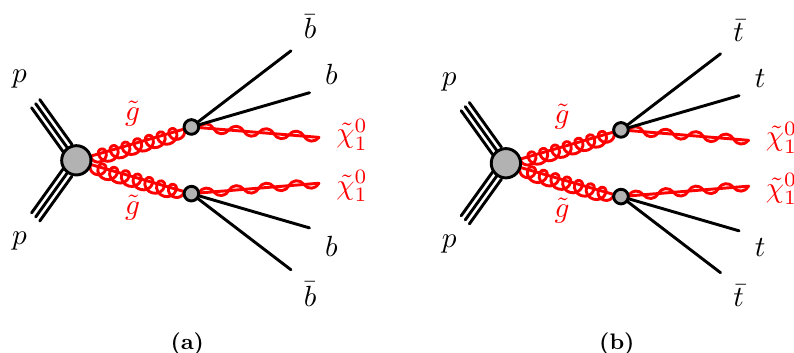
Figure 1. The decay topologies in the (a) Gbb and (b) Gtt simpli(cid:12)ed